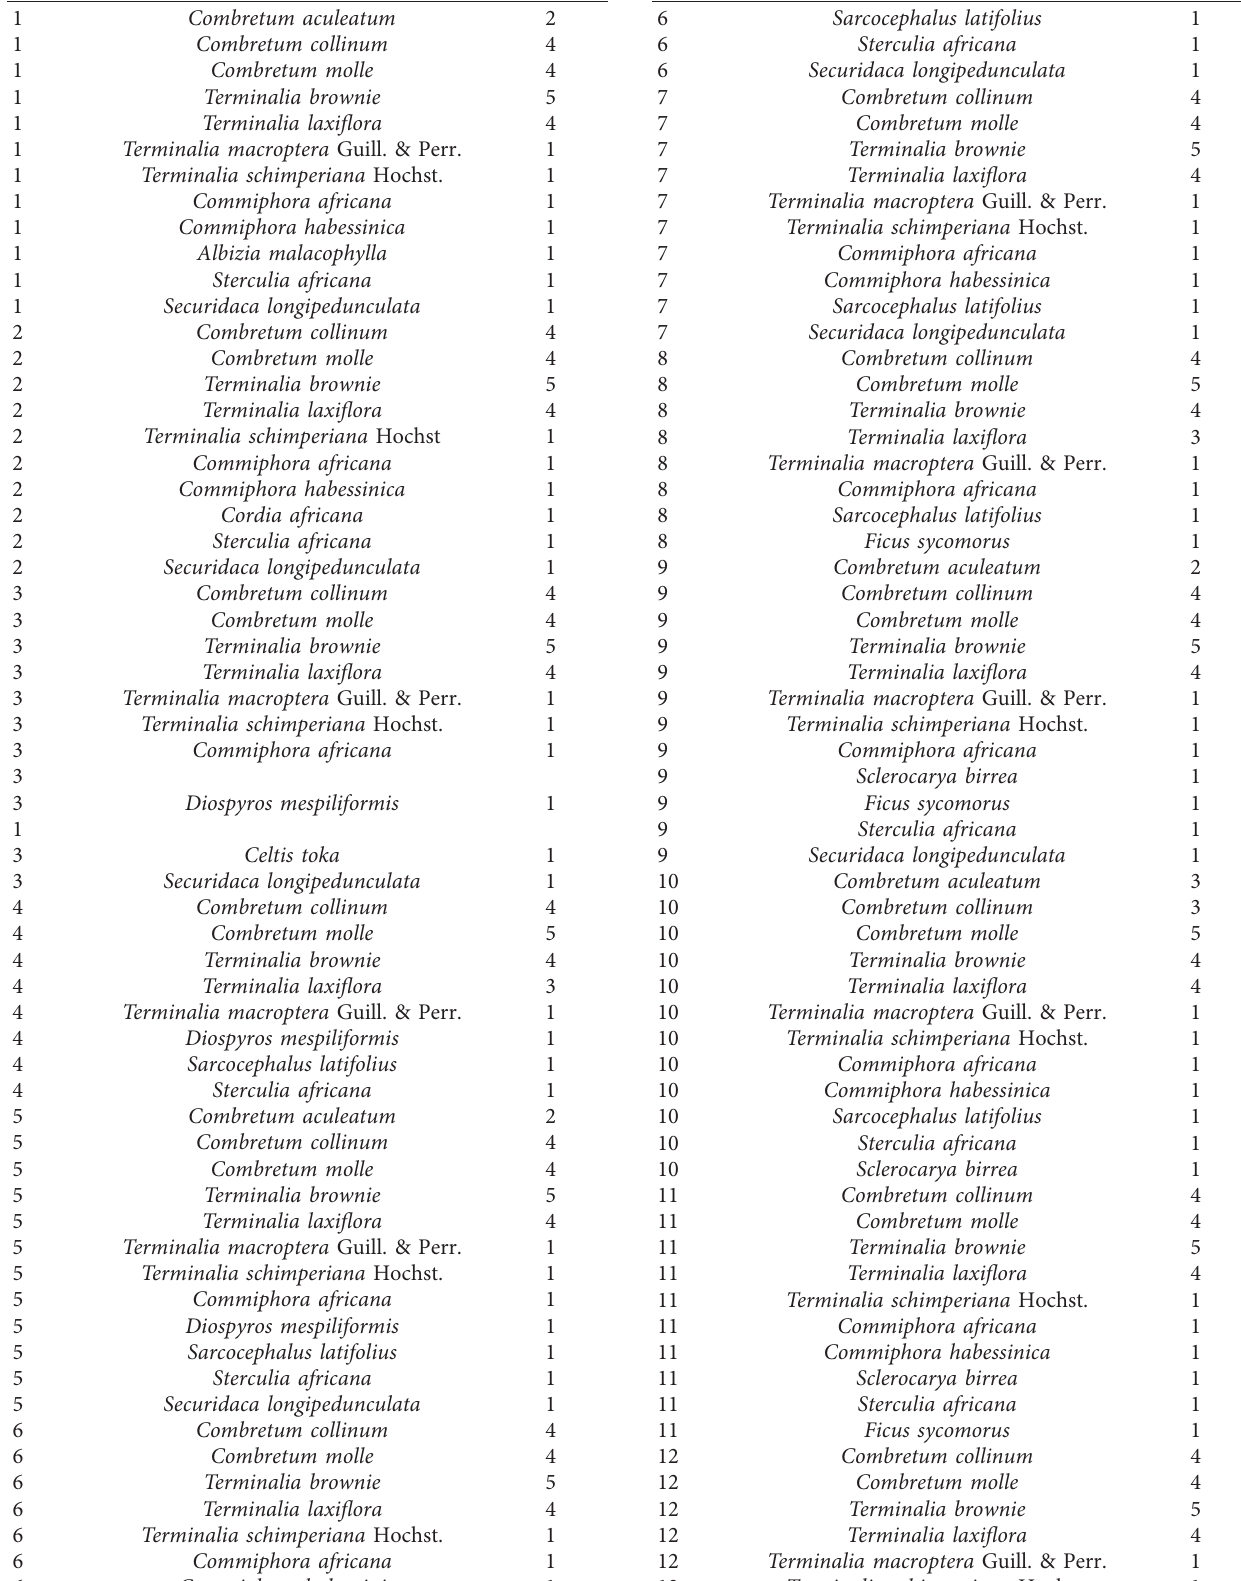
Table 3: Data for vegetation abundance of Gambella National Park. Plot